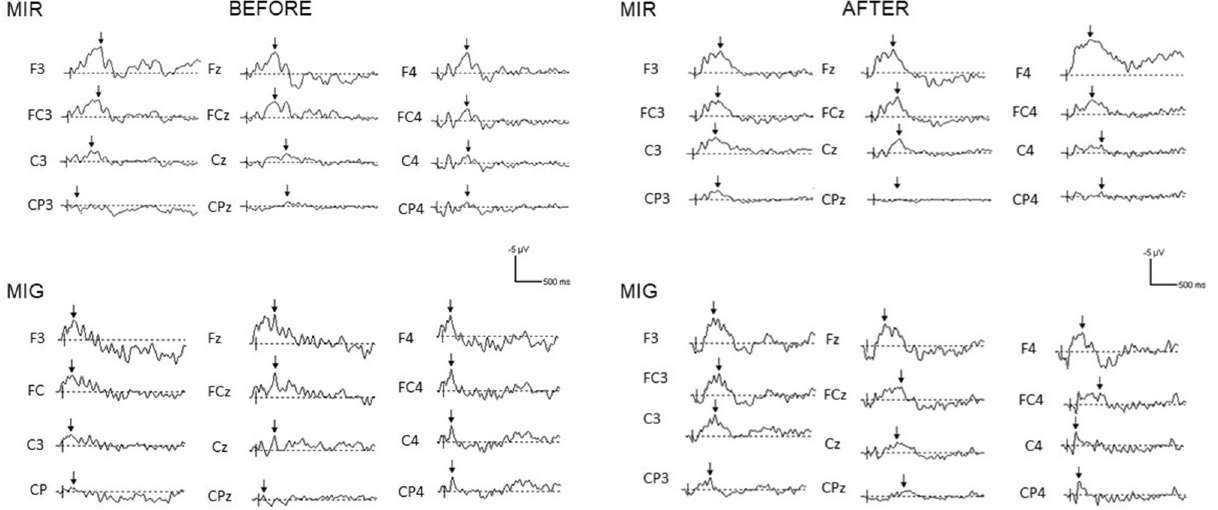
Figure 4. Individual patterns of ERP during motor imagery of reaching (MIR) and motor imagery of grasping (MIG) for chosen electrodes and measurement sessions (before and after). The vertical lines indicate the time of occurrence of the trigger, and the arrows indicate the ERP amplitude.